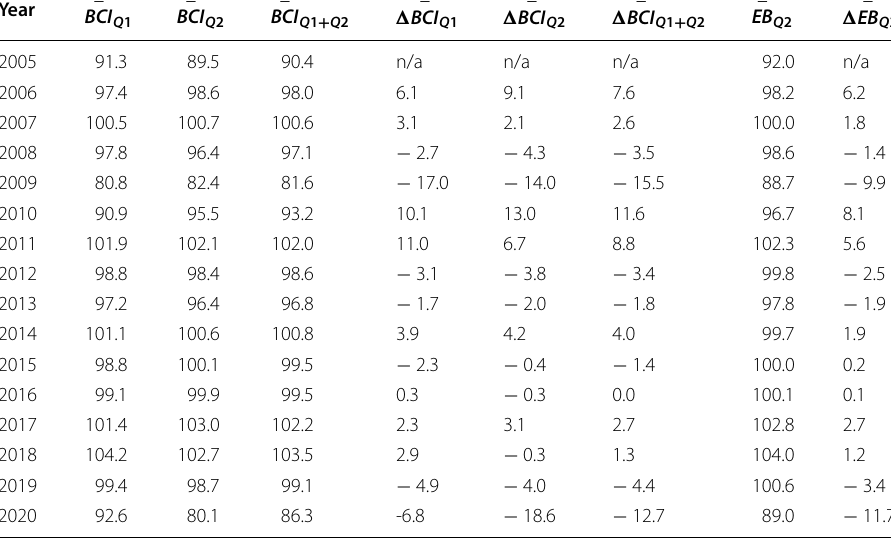
Table 1 Yearly changes in the ifo Business Climate Index (BCI) and the ifo